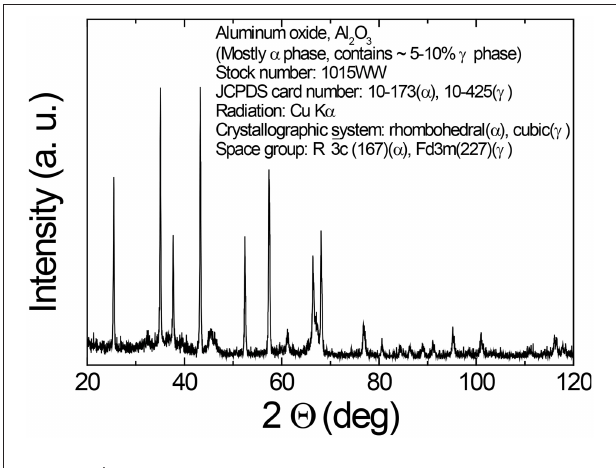
FIGURE 2 | XRD analysis of nano alumina. TABLE 2 | Mix proportions of high volume slag and high volume slag-fly ash blend cement pastes containing nano alumina